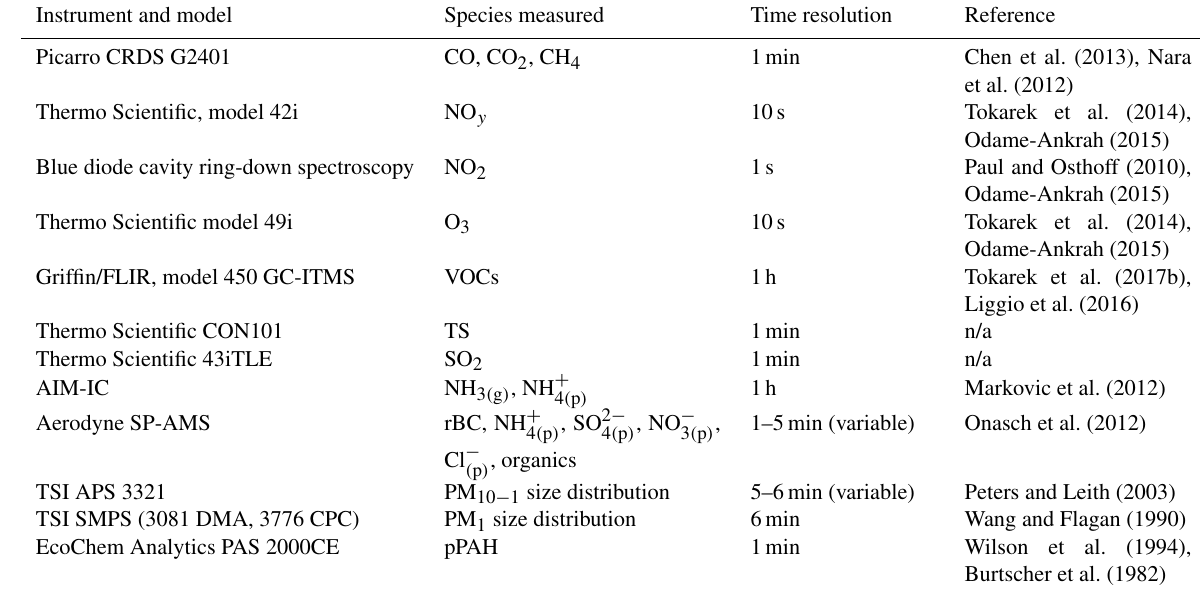
Table 2. Instruments used to measure ambient gas-phase and aerosol species during the 2013 JOSM intensive study at AMS 13. Instrument and